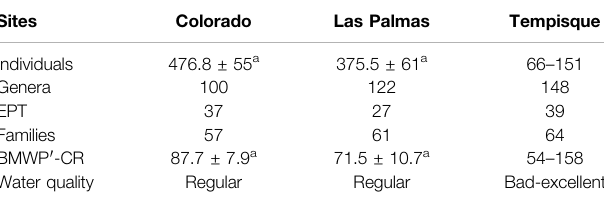
TABLE 2 | Mean number of individuals, total number of genera, EPT genera (Ephemeroptera + Plecoptera + Trichoptera), total amount of families, and mean values for the BMWP ′ -CR index with resulting biological water quality in the different collecting sites. Means in the same row with the same lettering are not signi fi cantly different (ANOVA, homocedastic model, DGC-Test, p > 0.05). Tempisque localities were sampled only once and cannot be analyzed using an